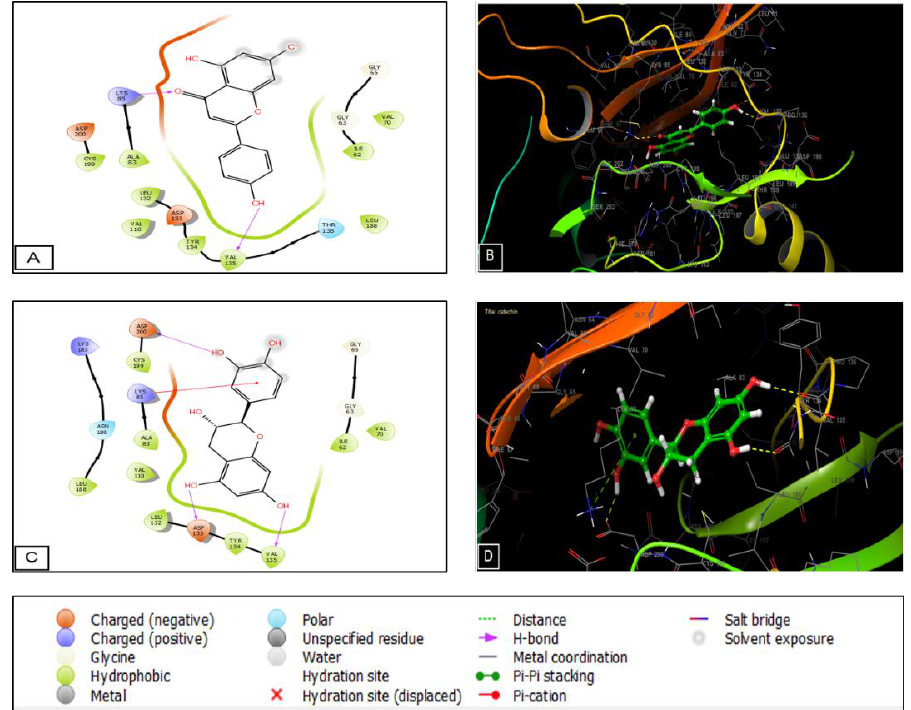
Figure 8. Diagrams showing the interactions between apigenin and the GSK3- β receptor’s active sites are shown in ( A ) 2D and ( B ) 3D. Diagrams of the catechin interactions with the GSK3- β receptor’s active sites are shown in ( C ) 2D and ( D ) 3D.